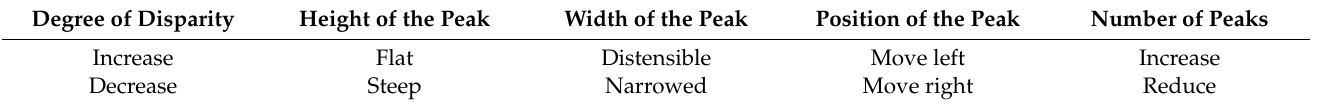
Table 1. Correlation between density curve and degree of disparity. Degree of Disparity Height of the Peak Width of the Peak Position of the Peak Number of Peaks Increase Flat Distensible Move left Decrease